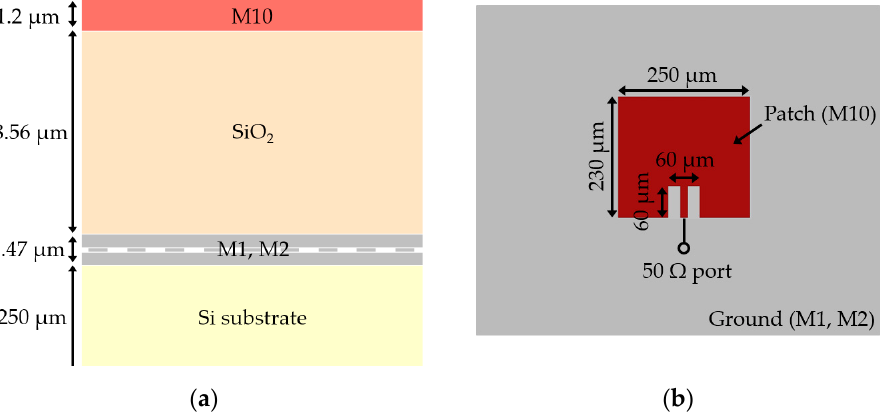
Figure 1. ( a ) Back-end-of-line (BEOL) structure of 65 nm CMOS process and ( b ) reference patch antenna .